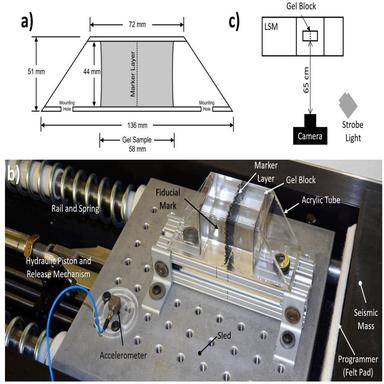
a) Dimensions of the gel block and acrylic tubing. Note that the gel sample is shown in gray. b) Linear shock machine (LSM) with the gel block inside acrylic tubing. c) Diagram of the camera placement relative to the LSM and gel block.